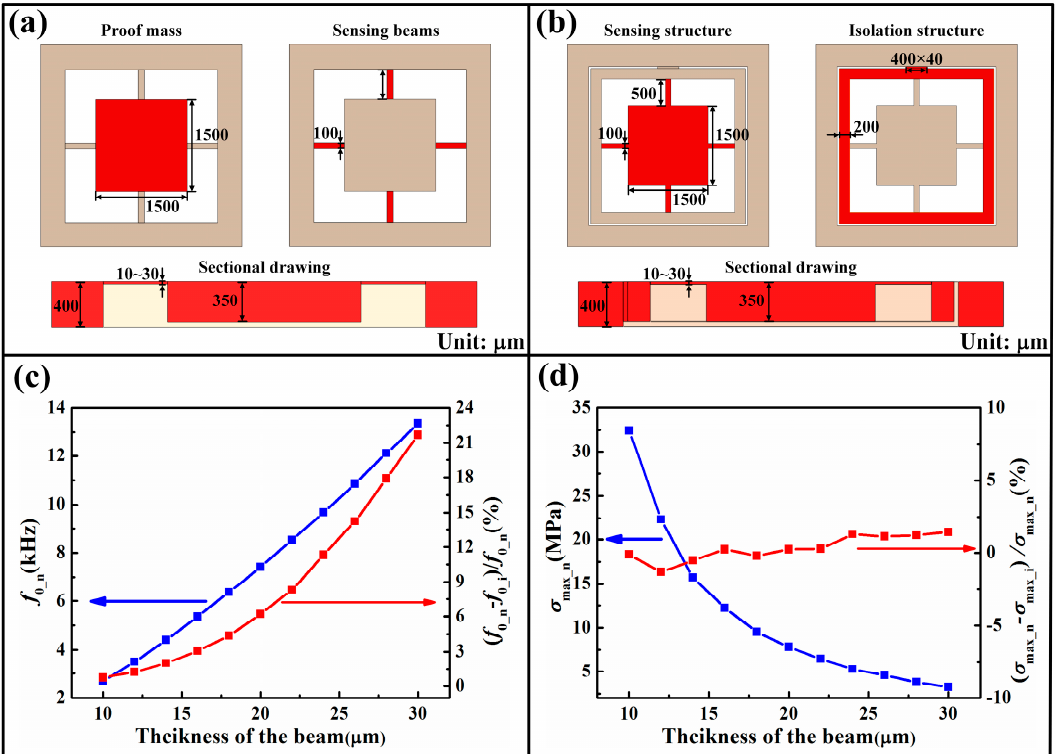
Figure 11. Models and simulation results: ( a ) Model and dimensions of the sensor without GR; ( b ) Model and dimensions of the sensor with GR; ( c ) Simulation results of resonant frequency; ( d ) Simulation results of maximum normal stress in the beams.